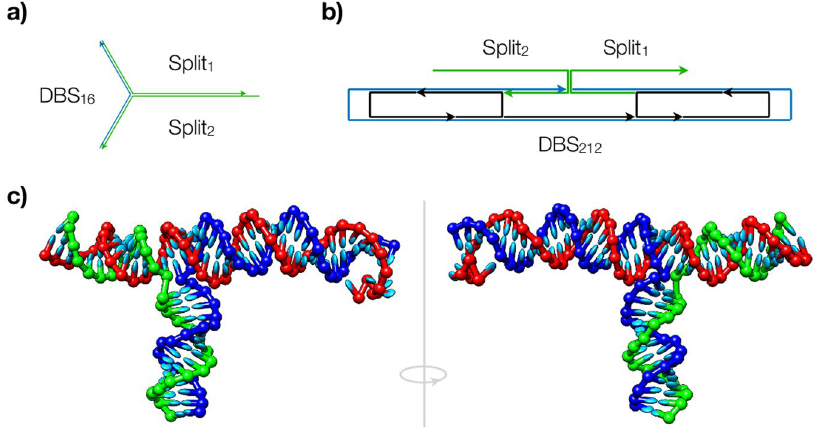
Figure 1. The overview of the designs used in this study. ( a ) Split1, Split2 and the complementary DBS forming a three-way junction; ( b ) RNA origami ribbon decorated with the Split1 and Split2 staples which bind to the opposite ends of the DBS scaffold; ( c ) visualisation of the three-way junction MFE structure as simulated by oxRNA coarse-grained model (DBS in red, Split1 in blue, Split2 in